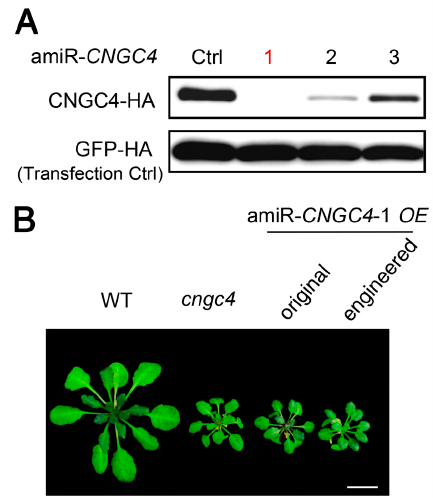
Figure 4. amiRNAs produced from the engineered pre-miR319a are fully functional. (A) Comparison of the silencing efficiency of three CNGC4 -targeting amiRNAs expressed from the engineered pre-miR319a using the ETPamir assay. Note that amiR- CNGC4 -1 (red) is the most potent amiRNA for silencing CNGC4 . Three independent repeats with GFP-HA as an untargeted internal control produced similar results. (B) Comparison of the performance of amiR- CNGC4 -1 produced from the original or engineered amiRNA precursor in transgenic plants. cngc4 is a T-DNA insertion null mutant of CNGC4 . Scale bar, 0.5 cm.